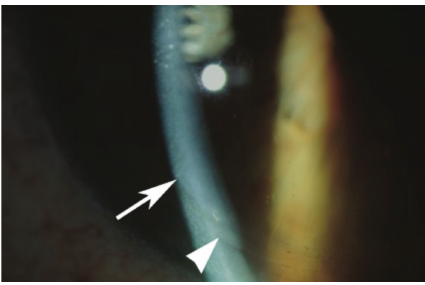
Figure 1: Postoperative appearance of femtosecond laser-assisted LASIK on a patient with DSAEK. The LASIK flap (arrow) and the DSAEK layer (arrowhead) are